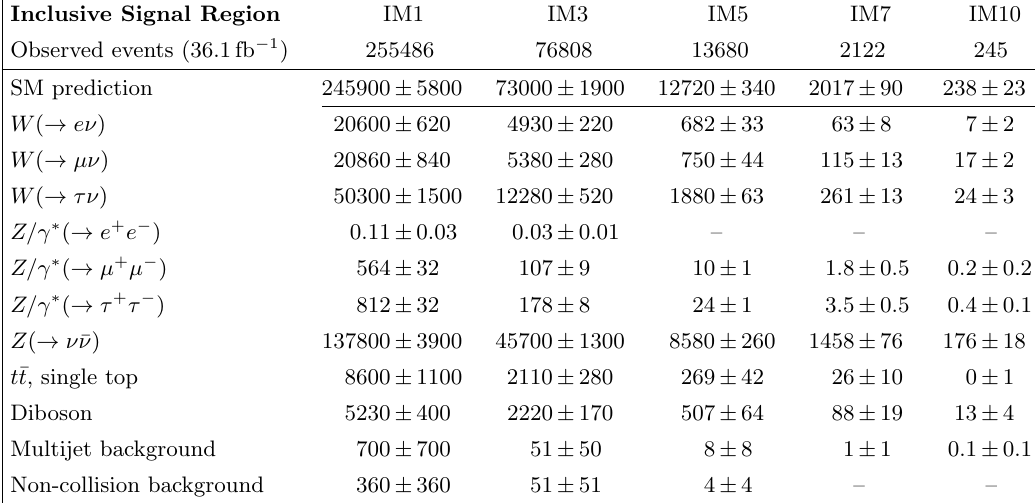
Table 3 . Data and SM background predictions in the signal region for several inclusive E miss selections, as determined using separate one-bin likelihood (cid:12)ts in the control regions. For the SM prediction, both the statistical and systematic uncertainties are included. In each signal region, the individual uncertainties for the di(cid:11)erent background processes can be correlated, and do not necessarily add in quadrature to the total background uncertainty. The dash \{" denotes negligible background contributions.